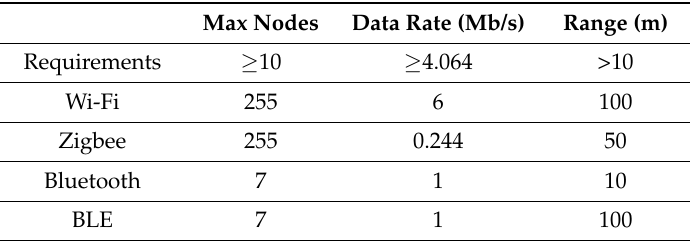
Table 1. Comparison of wireless networking protocols [14,16]; data rates are theoretical